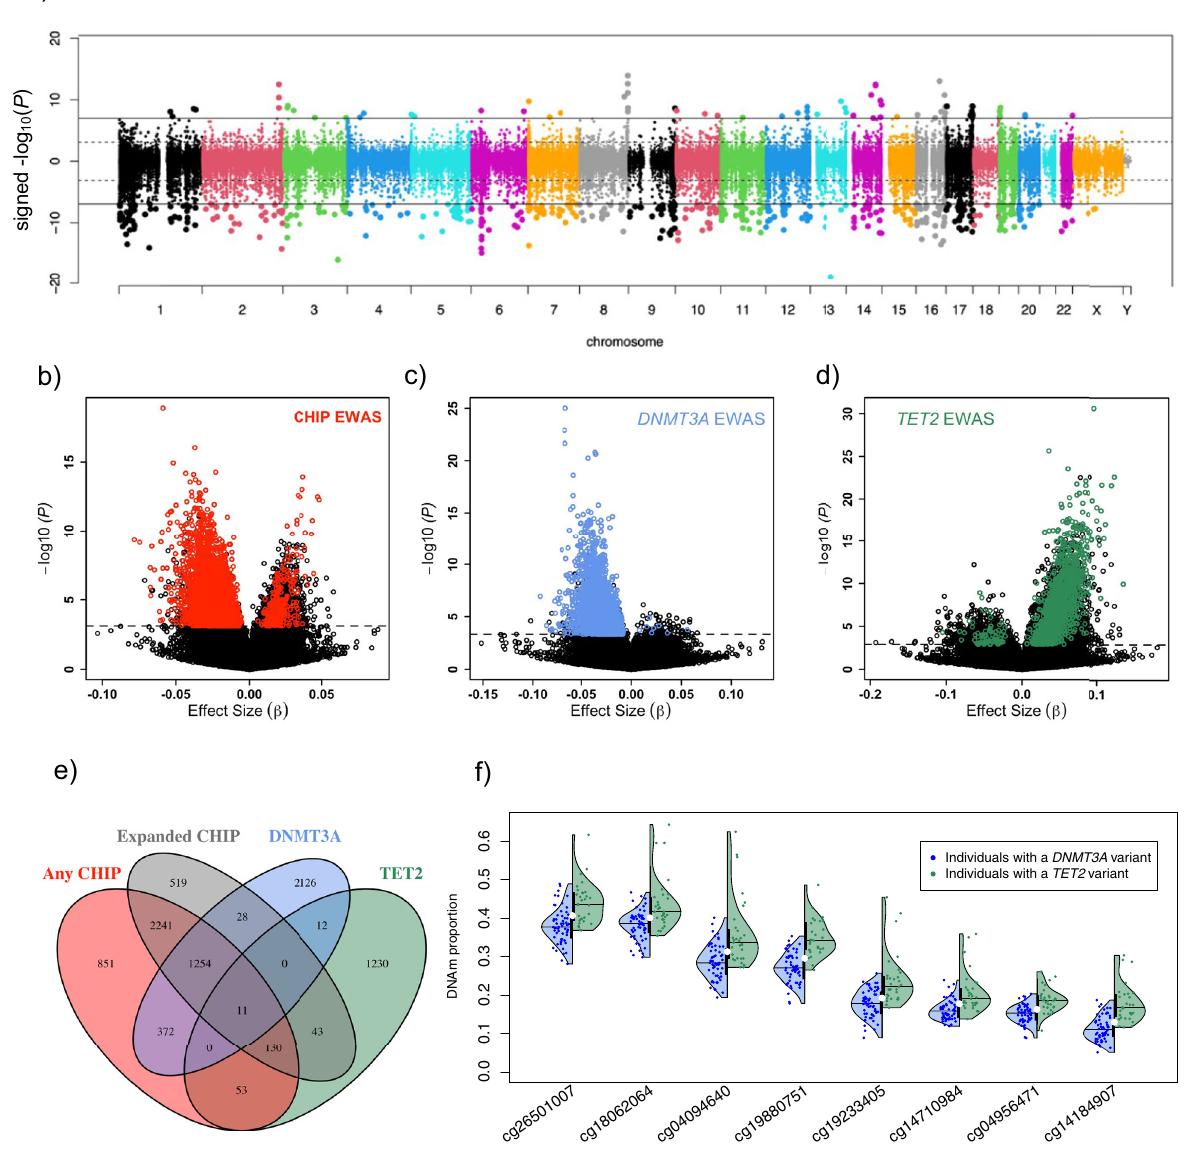
c DNMT3A CHIP, and d) TET2 CHIP. Dashed line indicates FDR<5%, and colored points highlight CpGs replicated in ARIC cohort. e Overlap of replicated CpGs among the four CHIP EWAS. f Distribution of DNAm at the eight most signi fi cant replicated CpGs associated with both DNMT3A and TET2 . Colored points show DNAmproportionsateachCpGforindividualswith DNMT3A (blue)or TET2 (green) CHIP,overlaid bydensity functions for each group and lines representing medians of each distribution. For comparison, medians for individuals without CHIP are shown as white